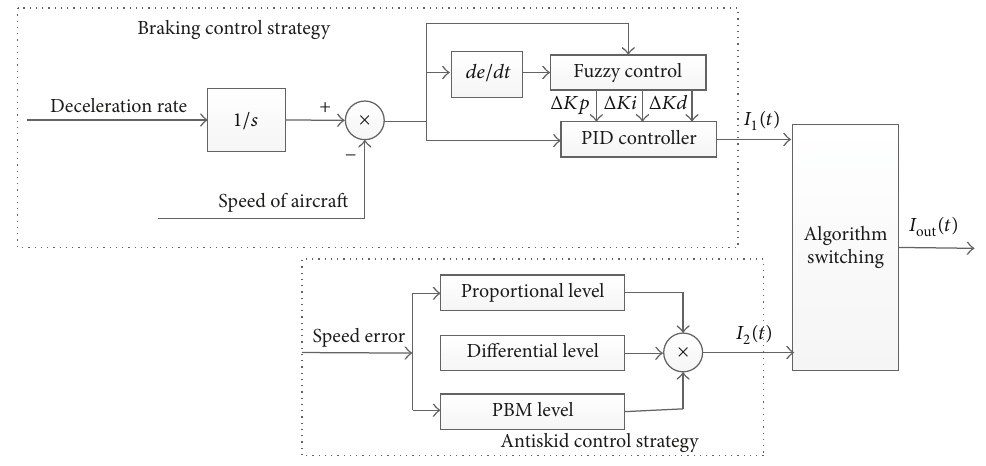
Figure 4: The control strategy of braking system.